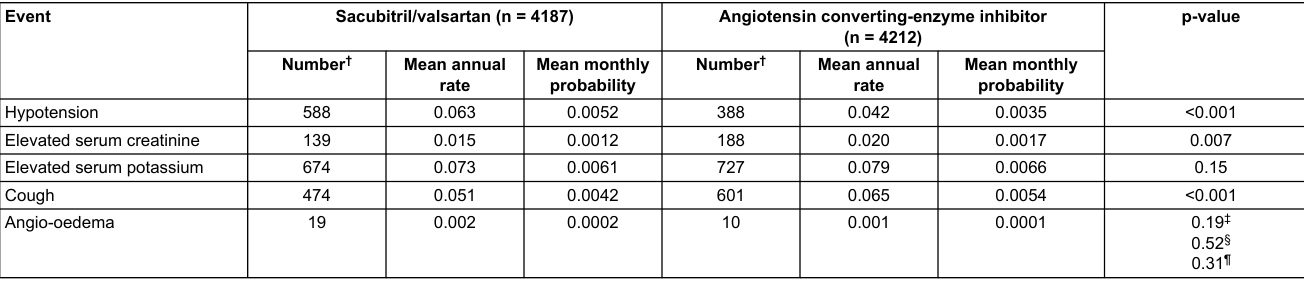
Table S8: Occurrence of less serious adverse events in the PARADIGM-HF